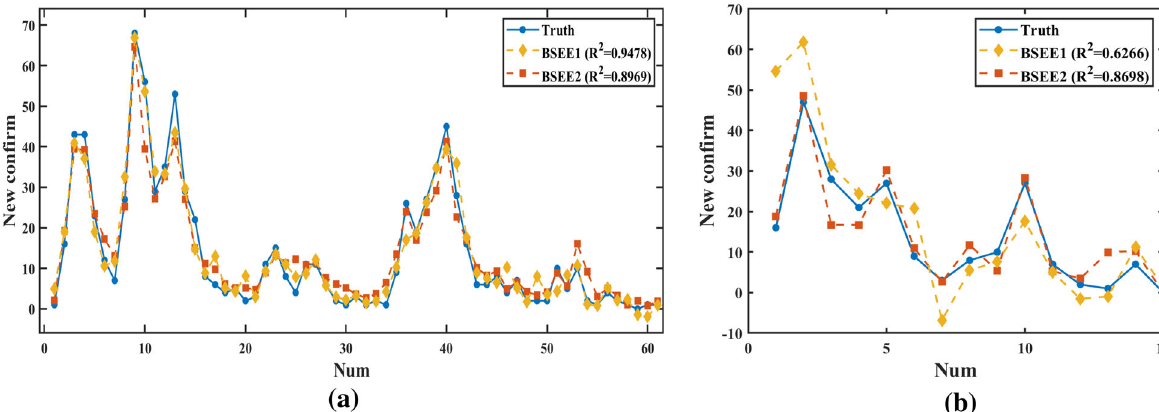
Fig. 5 Comparison of regression effects of two kinds of BSEE. a Training set, b test set.